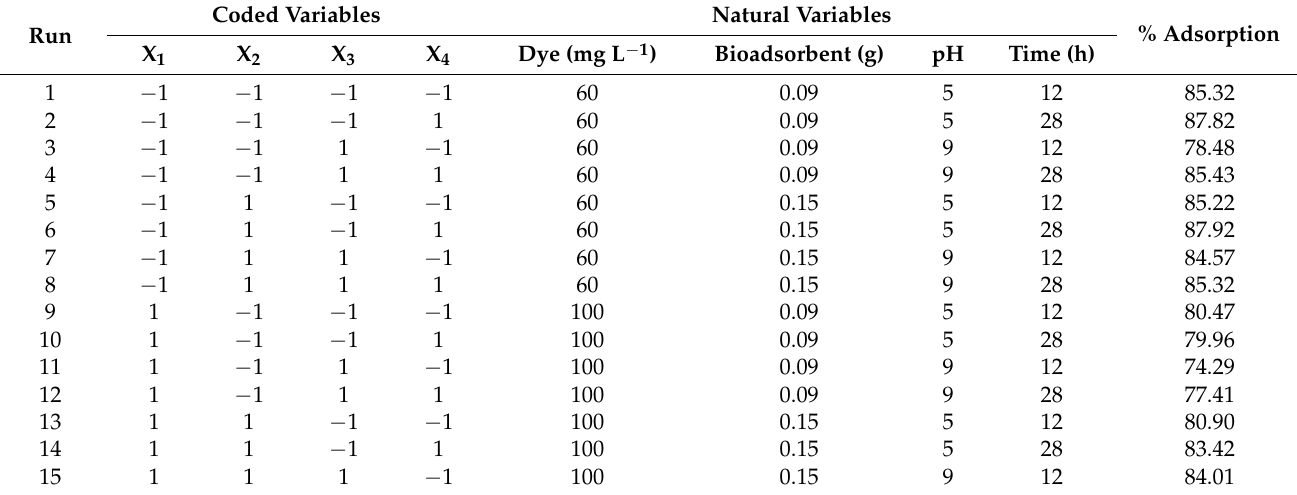
Table 2. Runs for the experiment on the process of adsorption of Congo red